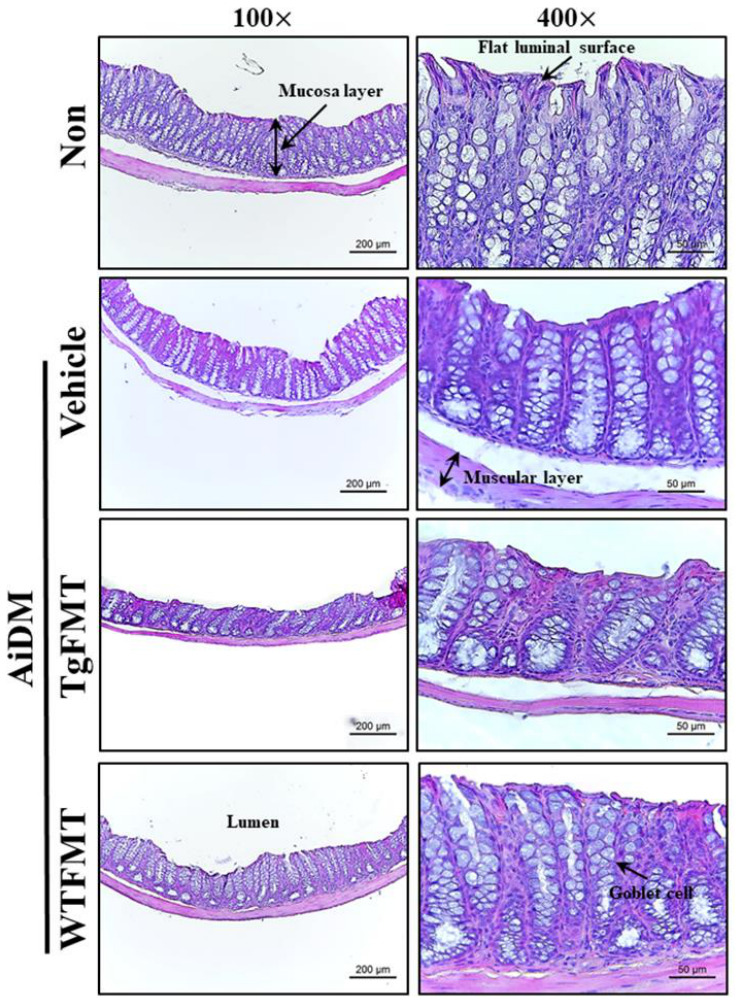
Figure 7. Histopathological structures of the mid colon in the AiDM+TgFMT mice. After staining the sections of the mid colon with H&E solution, histopathological structures were observed and characterized at 100× ( left column) and 400× ( right column) using an optical microscope. H&E- stained slides of the mid colon were prepared from four to six mice per group, and each parameter in their structure was measured in duplicate. Abbreviations: WT, wild-type; Tg, Tg2576 mice; FMT, fecal microbiota transplantation; TgFMT, Tg2576 mice FMT; WFMT, wild-type mice FMT; AiDM, antibiotics-induced depletion of